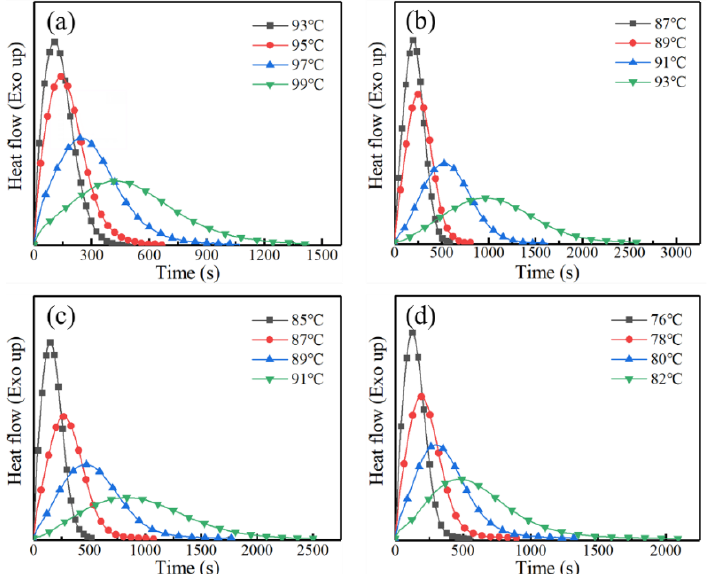
Figure 4. The time-dependent exothermal curves of polyesters isothermally crystallized at specified temperatures. ( a ) PBS, ( b ) PBSAD-5, ( c ) PBSAD-7, and ( d )